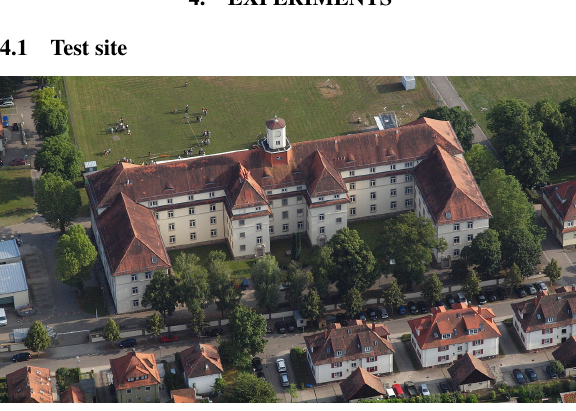
Figure 2. Aerial view of the test site 7 .